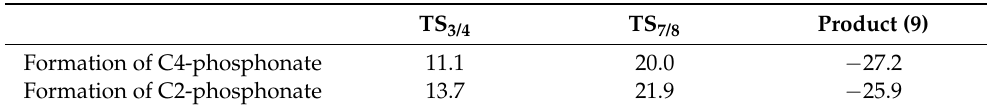
Table 1. The free energy barriers of key elementary reactions and energies of the C2- and C4- phosphonate products (unit kcal/mol). TS 3/4 TS 7/8 Formation of C4-phosphonate